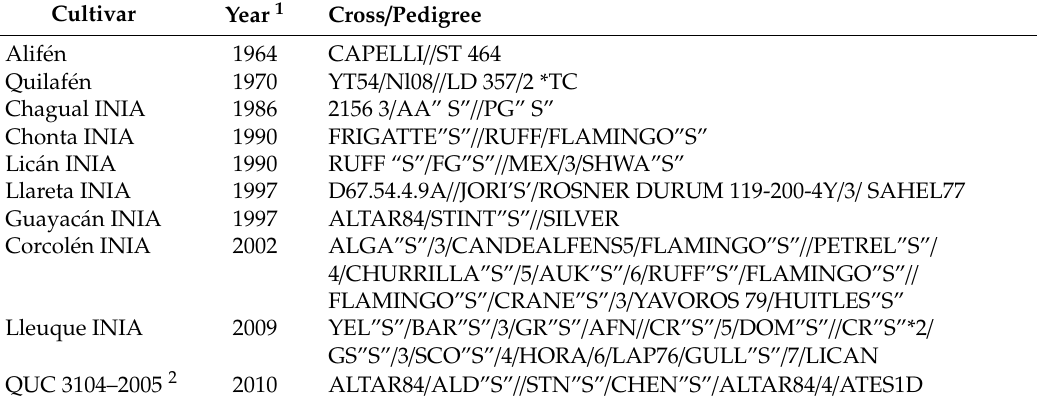
Table 1. Cultivars of durum wheat released by the wheat breeding program of the Chilean INIA between 1964 and